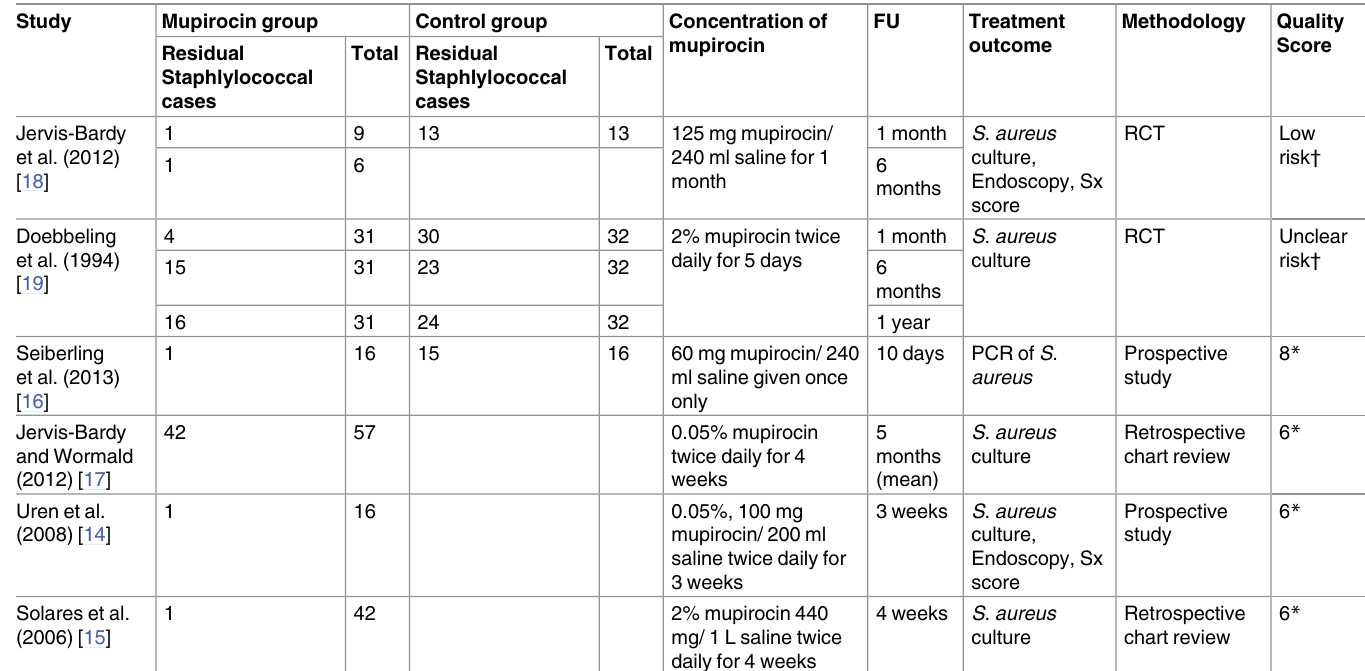
Table 1. Demographics of included studies